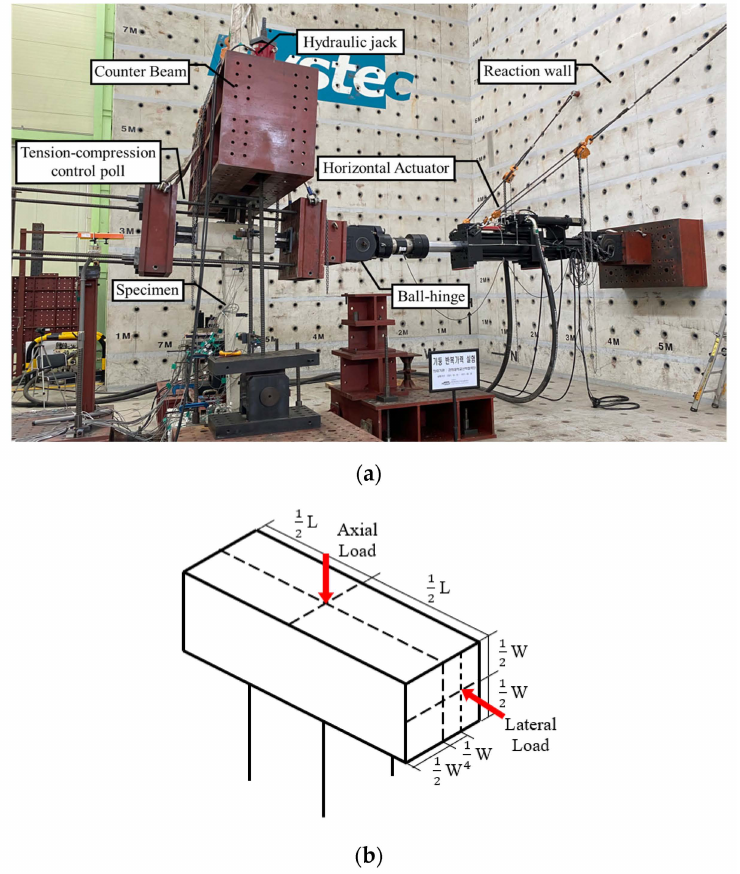
Figure 4. Experimental setup for the combined cyclic loading test: ( a ) Test setup; ( b ) Loading